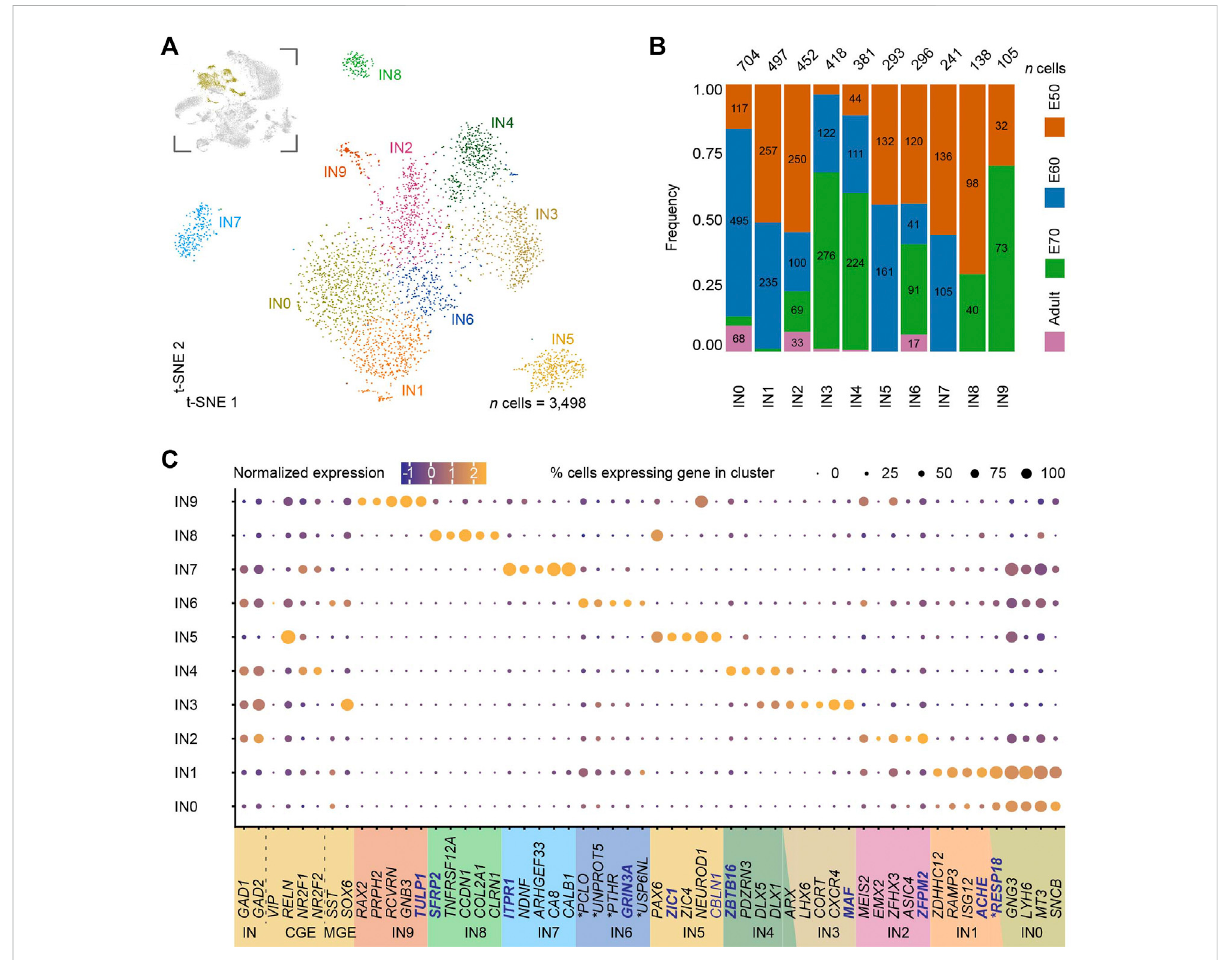
FIGURE 2 Subclustering of medial entorhinal cortex (MEC) interneurons (INs) reveals ten clusters with unique gene signatures. (A) A t-SNE plot of the subclusteringidentifyingteninterneuron(IN)clusterswithoneclustermoretranscriptionallydistinctthantheothers.INclustershighlightedinyellow in the inset image were subclustered from the parent dataset and are depicted in the top left corner. (B) An analysis of the developmental stages across the ten clusters highlights IN1, IN5, IN7, IN8 and IN9 are found exclusively during development and suggestive of IN progenitors and the remainingclustersareadultINs. (C) Uniquegenesignatureswereidenti fi edforthetenclustersbydifferentialgeneexpressionanalysis,togetherwith the population speci fi c expression of canonical markers for interneurons (IN) derived both from the caudal ganglionic eminence (CGE) and the medial ganglionic eminence (MGE). Localization of genes with names in blue are shown in (D) . The p marks the human ortholog names (Supplementary Table